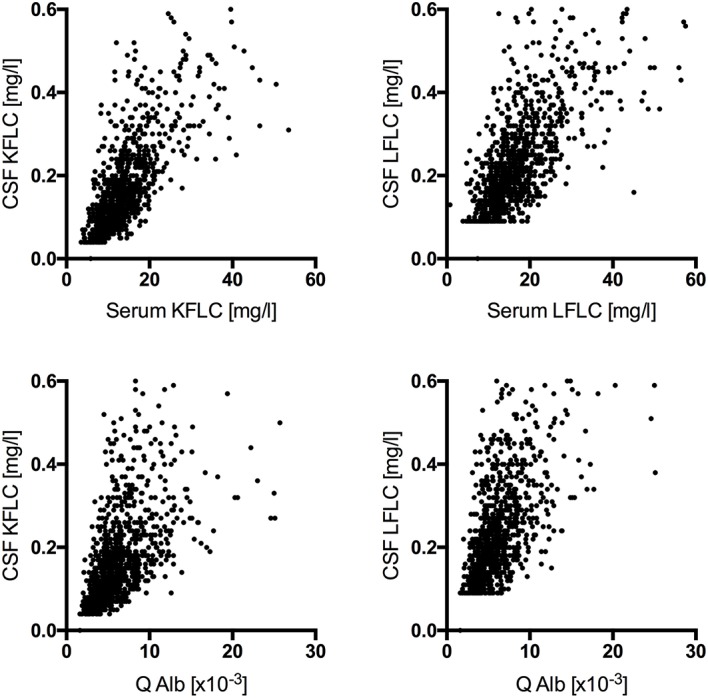
Correlation among cerebrospinal fluid free light chain levels in non-inflammatory neurologic diseases (n = 989) with the respective serum levels (KFLC: p < 0.001, r = 0.744; LFLC: p < 0.001, r = 0.737) and the respective CSF-serum ratio of albumin (Q Alb) (KFLC: p < 0.001, r = 0.638; LFLC: p < 0.001, r = 0.653) are shown.